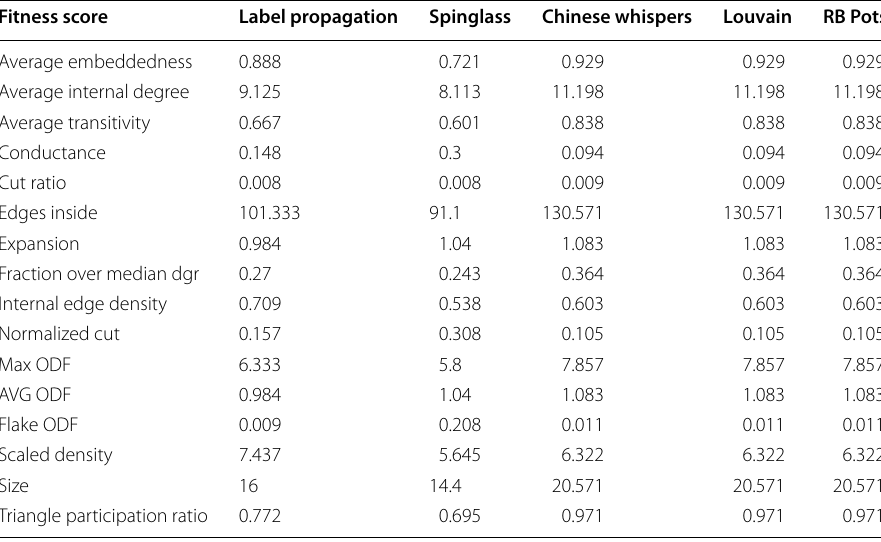
The higher the fitness score, the better the results